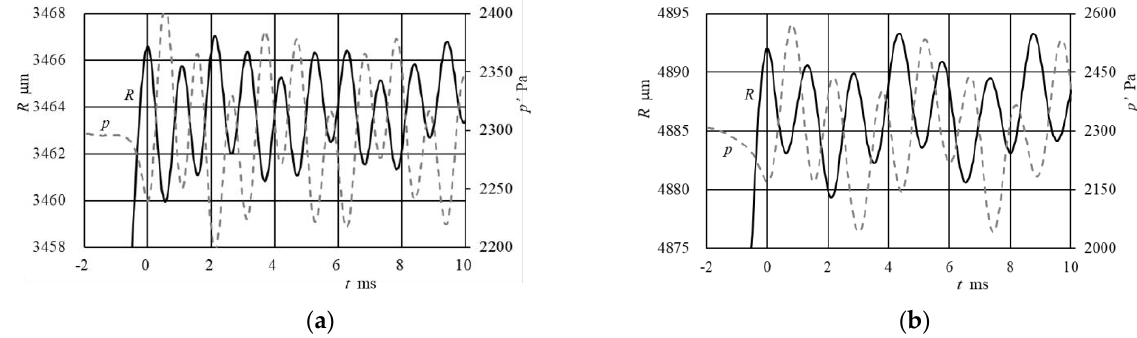
Figure 13. Radius variation of bubble and pressure profile at the measuring point. ( a ) φ = 6 mm. ( b ) φ = 10 mm.